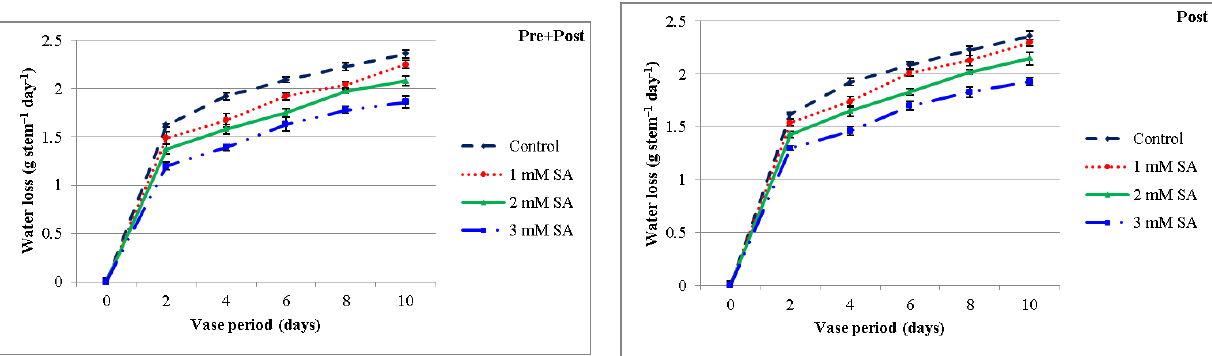
Fig. 3. Effect of pre + post-harvest and post-harvest applications of different concentrations of salicylic acid on water loss (g stem -1 day -1 ) of cut alstroemeria flowers during vase period. The results represent the means of 12 cut flowers in 4 replicates ± standard errors